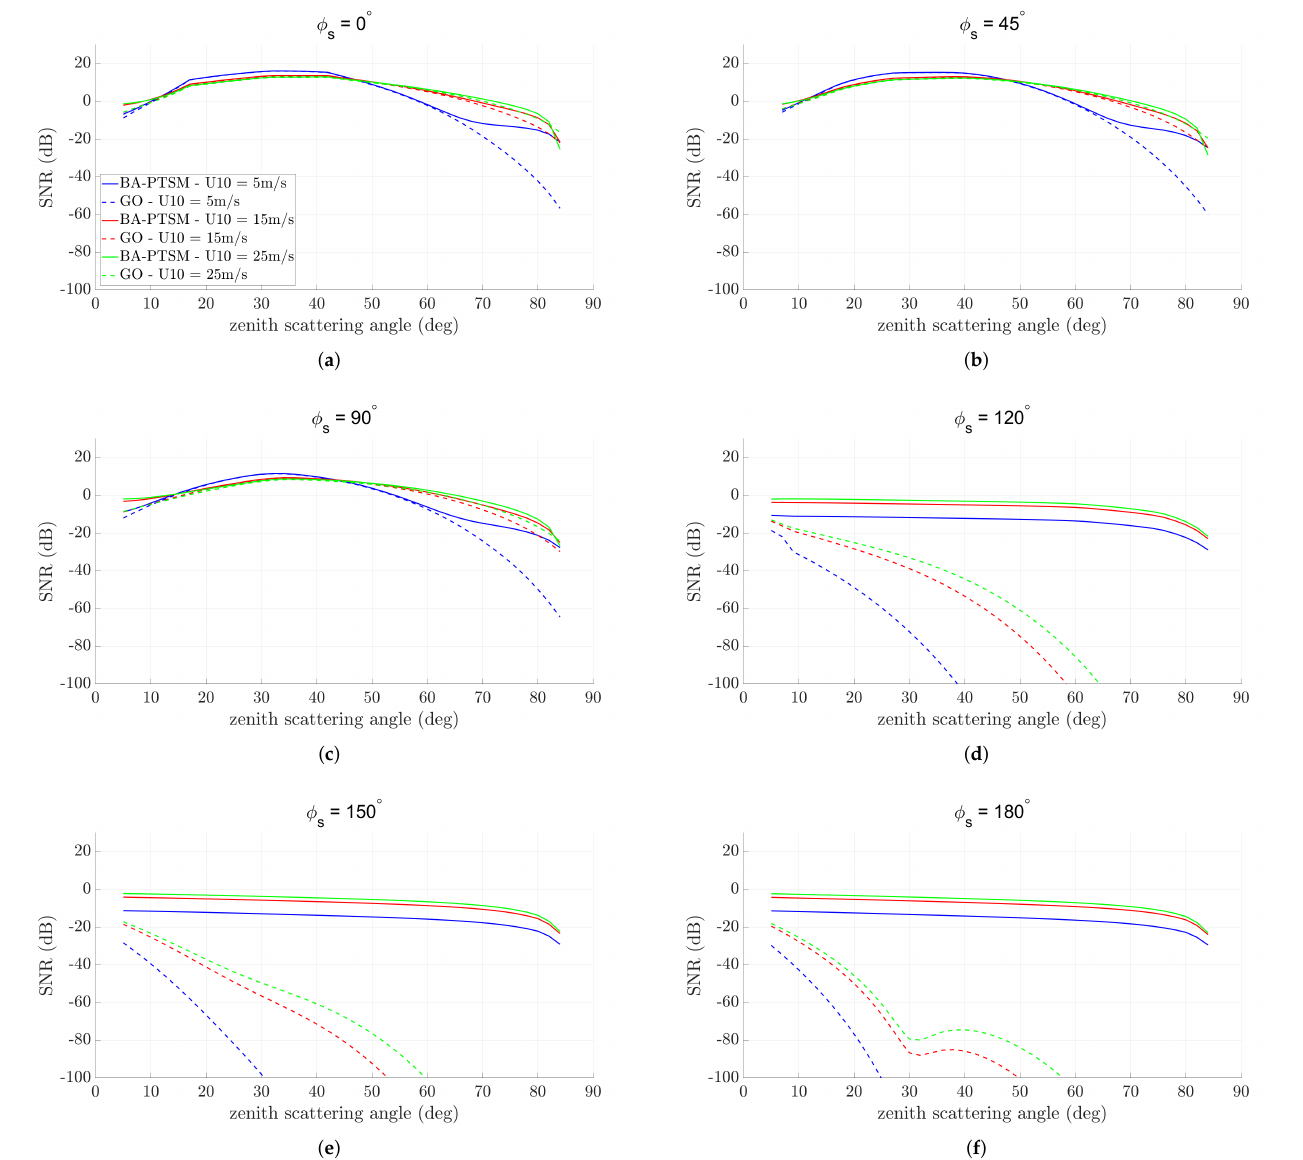
Figure 6. SNR in RR polarization for an airborne GNSS-R receiver obtained using BA-PTSM (solid lines) and GO (dashed lines) for wind speed 5 m/s (blue lines), 15 m/s (red lines), and 25 m/s (green lines). ( a ) φ s = 0 ◦ ; ( b ) φ s = 45 ◦ ; ( c ) φ s = 90 ◦ ; ( d ) φ s = 120 ◦ ; ( e ) φ s = 150 ◦ ; ( f ) φ s = 180 ◦